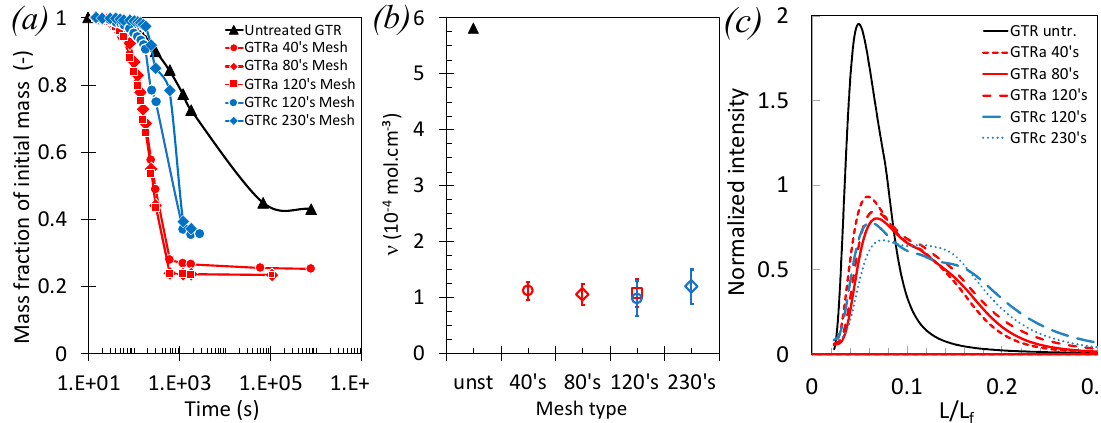
Figure 3. ( a ) Deswelling kinetics in swollen grinded GTR crumbs of different sizes displayed by mass fraction of the initial mass versus logarithmic time. ( b ) Network chains densities of grinded GTR crumbs of different particle sizes whose mesh types are detailed in the experimental section. ( c ) Normalized intensity versus normalized pores size of grinded GTR crumbs of different particle sizes extracted from thermoporosimetry experiments (see Experimental Section for more details on the procedure).